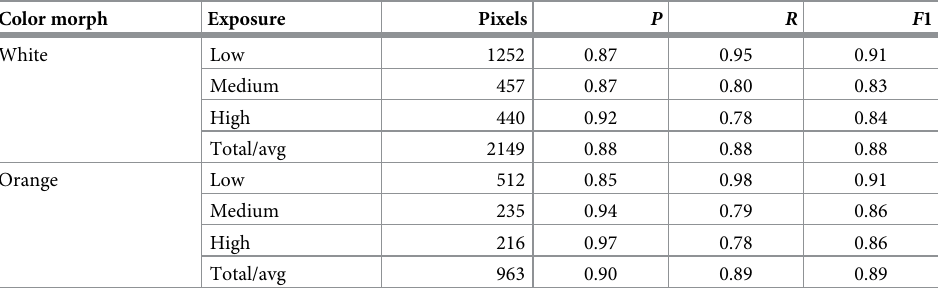
Classification results for the three-class case in terms of precision ( P ), recall ( R ), and F 1-score. An overall F 1 score of 0.88 and 0.89 is achieved for white and orange corals, respectively. The “pixels” column shows the number of spectra collected for each class. Note that average values refer to the harmonic